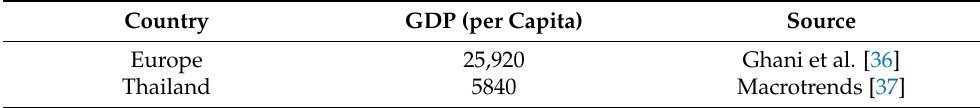
Table 4. GDP per capita (2015, USD) used to estimate environmental